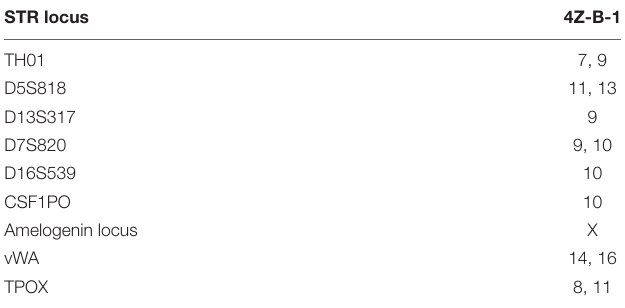
TABLE 2 | STR profile of the 4Z-B-1 cell